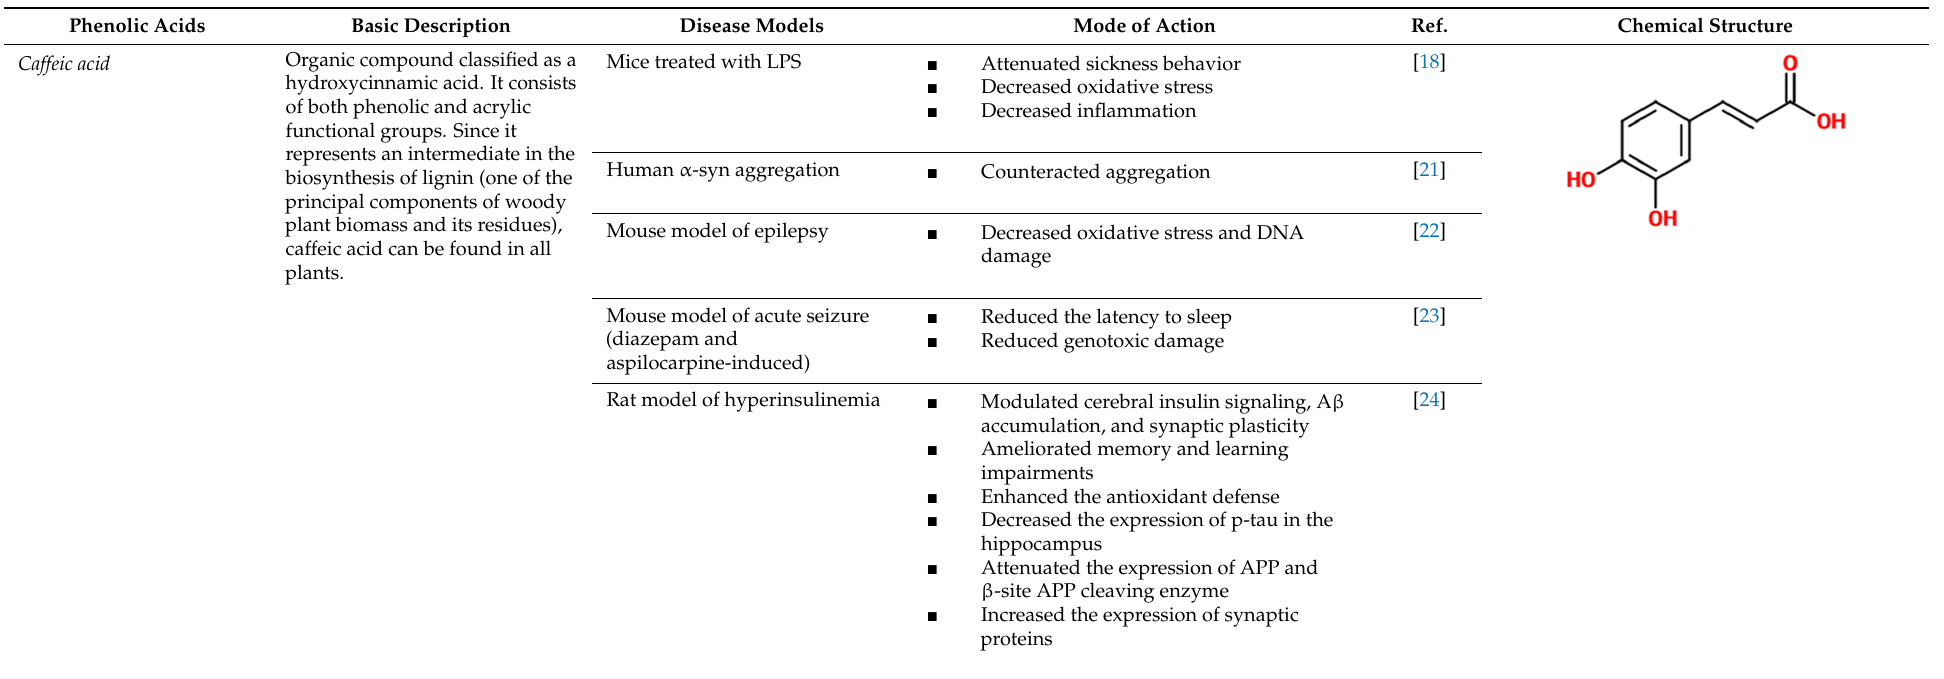
Table 1. Phenolic acids and related